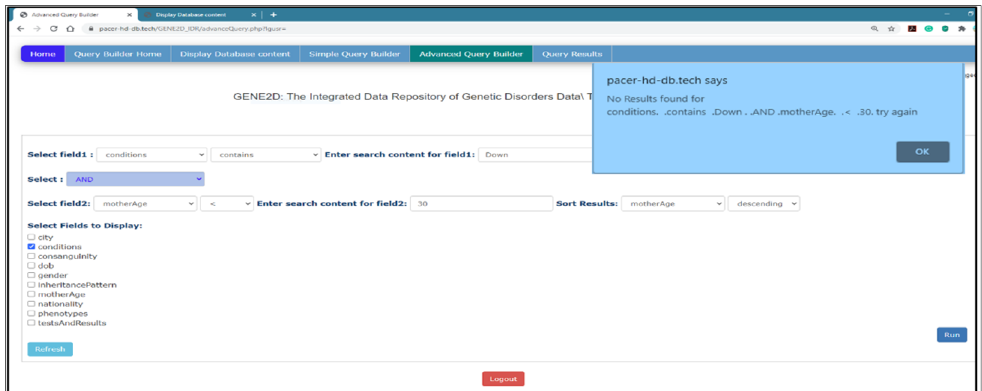
Figure 16. Informing messages.